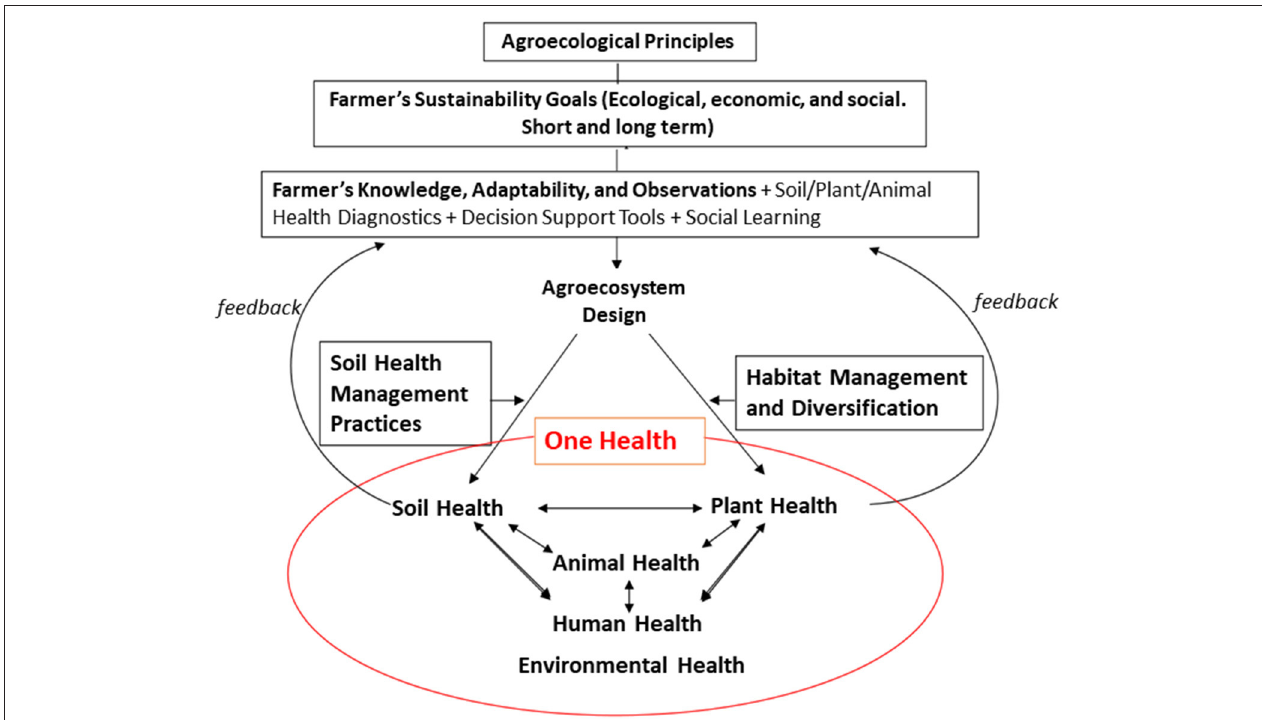
FIGURE 2 | Agroecosystem management and the concept of One Health. Integrated soil health management is embedded in this system. Agroecological principles include recycling, input reduction, soil health, animal health, biodiversity, synergy, economic diversification, co-creation of knowledge, social values and diets, fairness, connectivity, land and natural resource governance, and participation, according to a recent review by Wenzel et al. (2020). Habitat management and diversification have spatial (farm and landscape levels) and temporal dimensions. Environmental health includes the health of air and water. See Figure 1 for soil health diagnostics, decision support tools, and soil health management practices. Modified from Altieri and Nicholls